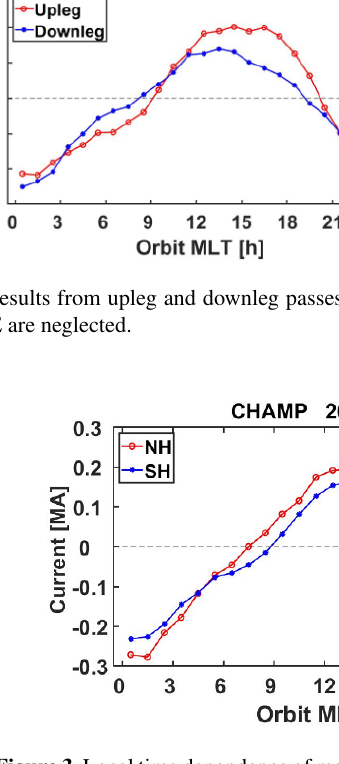
Figure 3. Local time dependence of mean auroral net currents; com- parison between the two